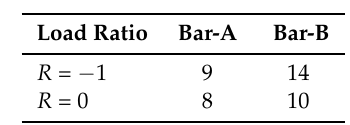
Figure 2. Fatigue test specimen. Table 2. Number of specimens tested for each bar and each load